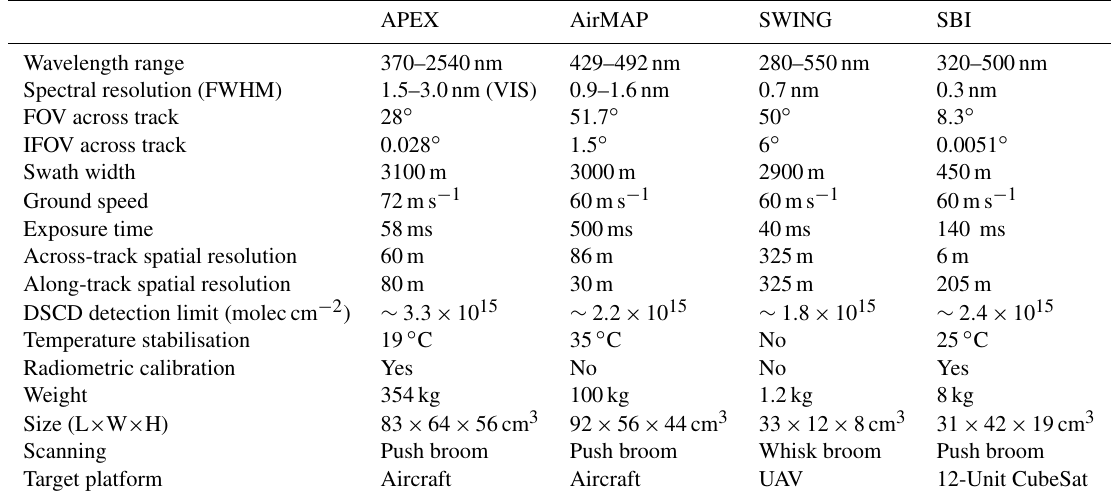
Table 2. Instrument specifications during the AROMAPEX campaign, defined for APEX for a typical altitude of 6.2kma.g.l. and for AirMAP, SWING, and SBI for a typical altitude of 3.1kma.g.l. Spatial resolutions are provided after applying spatial aggregation of the APEX and SBI spectra for signal-to-noise